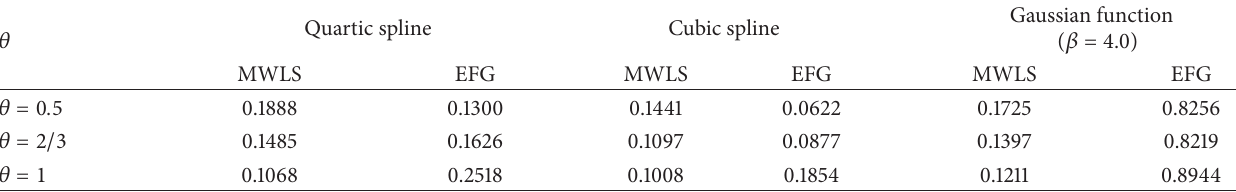
Table 1: RMS (%) error of different weight functions at 31 nodes for exposure time 𝑡 = 20 years.